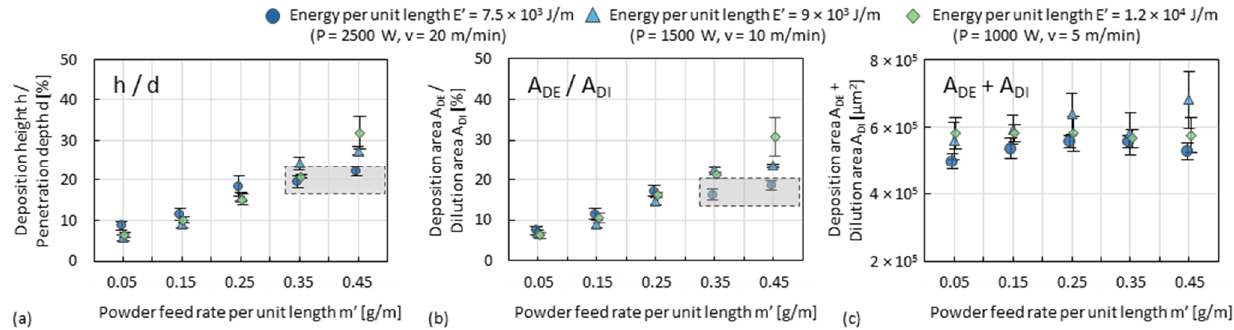
Figure 11 . Plot graphs of the index ( a ) ratio of h / d , ( b ) ratio A DE / A DI , and ( c ) sum A DE + A DI against m’ . Every point refers to the average value of three measurements.